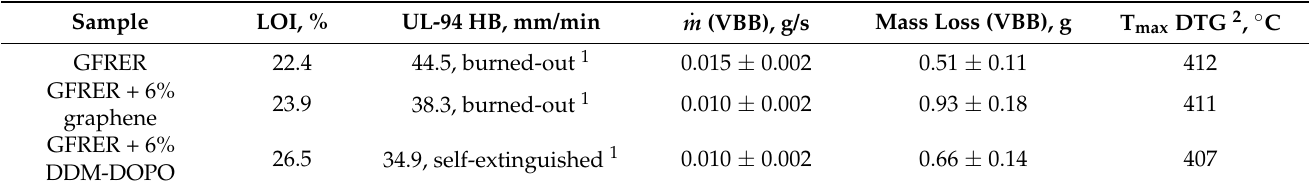
. m ); and the total mass loss  ); and the total mass loss